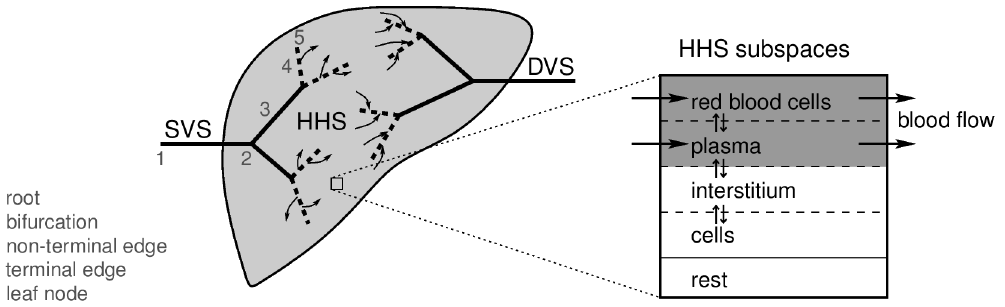
Figure 2. Conceptual two-dimensional sketch of our liver perfusion model. The homogenized hepatic space HHS is supplied and drained by the supplying vascular systems SVS and the draining vascular system DVS, respectively. The blood flow through the SVS summarizes the contributions of both supplying systems (hepatic artery and portal vein). The blood is hereafter transferred to the HHS along the terminal edges of the supplying vascular tree (dashed lines). After blood has passed through the HHS, flow into the draining vascular tree (hepatic vein) occurs again along its terminal edges (dashed lines). The HHS itself locally consists of several subspaces, the sinusoidal subspace (combining red blood cells and the plasma subspace), the interstitial subspace, the cellular subspace, and the remaining subspace. An actual 3D vascular geometry is shown in Figure 3. The SVS and DVS roots are connected to the rest of the body by the total blood flow in the liver. In the vascular structures, only 1D advection with given velocities per edge take place. In the HHS, 3D advection (according to a 3D flow velocity vector field) as well as exchange between the HHS subspaces and metabolization (according to PBPK model parameters) are considered simultaneously.